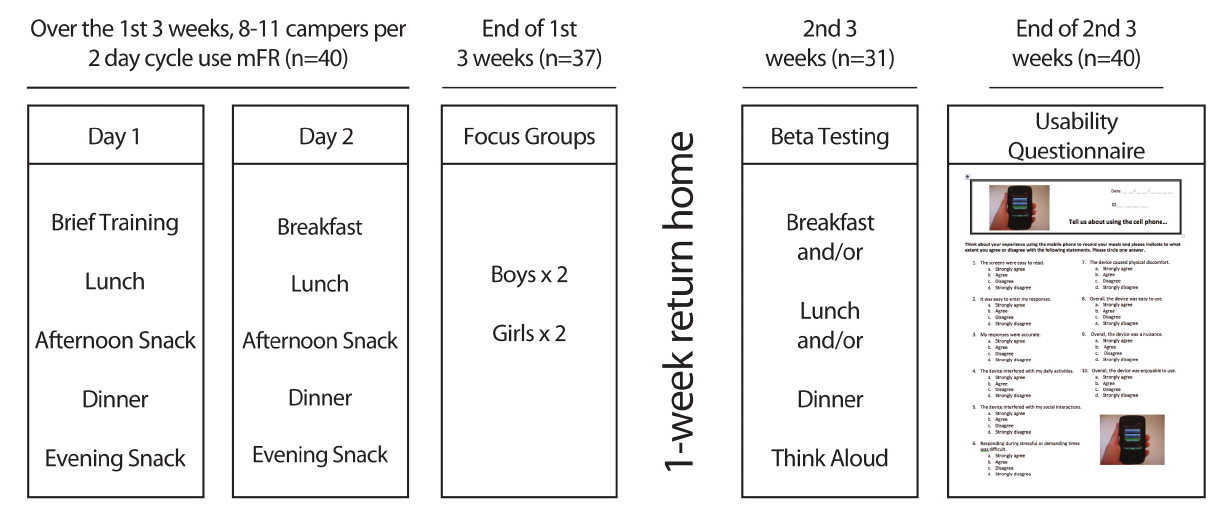
Figure 2. Mixed methods study design with quantitative and qualitative protocols.